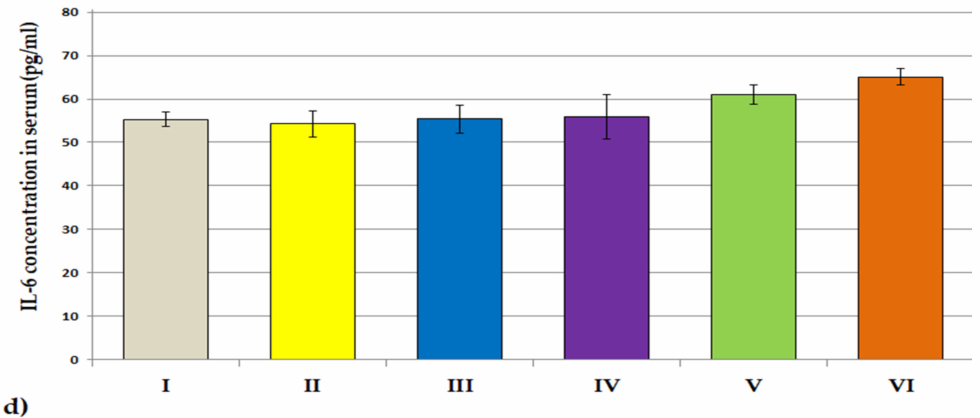
Figure 4. The influence of extracts on the ACHE ( a ) activity, BCHE activity ( b ), IL-1 β concentrations ( c ) and IL-6 concentrations ( d ) in the serum of rats. All values are reported as mean ± SEM ( n = 7). Significance: * p <0.05 vs. control group (one-way ANOVA followed by Tukey’s post hoc test). I— aqua pro injectione ; II— Narcissus triandrus L. 20 mg/kg; III— Lycopodium clavatum L. 10 mg/kg; IV— Lycopodium annotinum L. 10 mg/kg; V— Huperzia selago L. 10 mg/kg; VI— Angelica dahurica (sp.) 200 mg/kg.